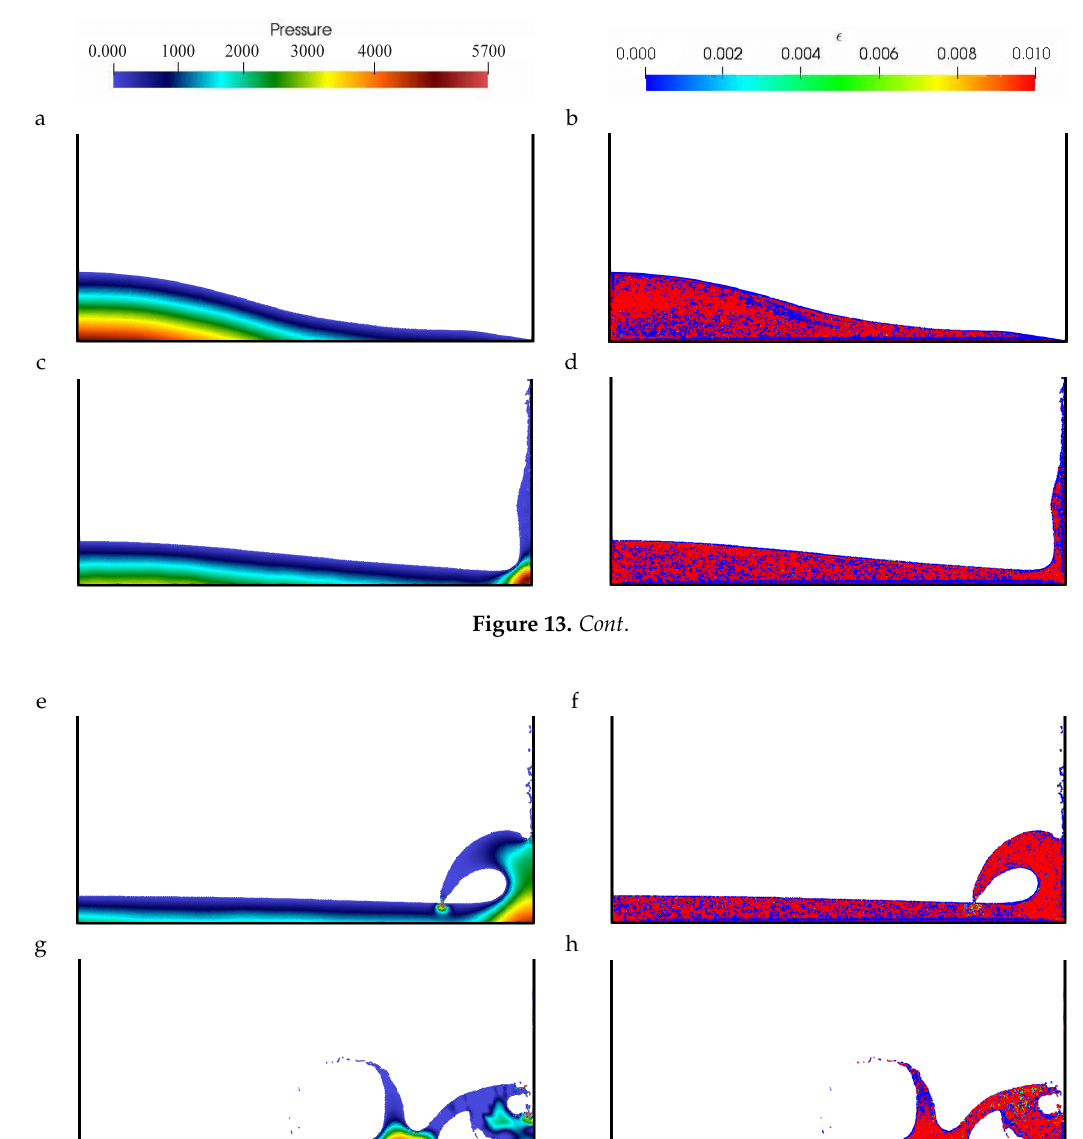
(cid:112) g / H = 4.04,